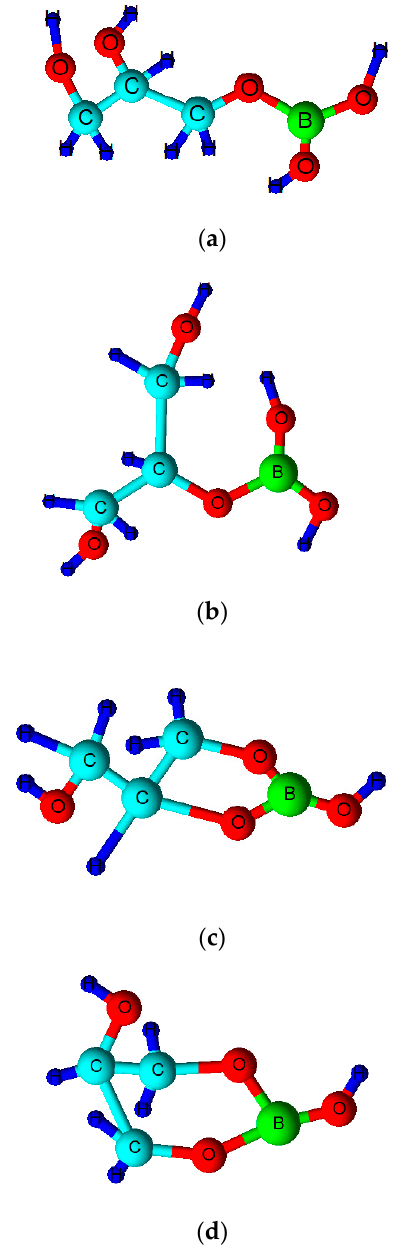
Figure 2. Molecular structures of boric acid/borate monoesters of glycerol. ( a ) sn -1(3)-monoester; ( b ) sn -2-monoester; ( c ) sn -1,2-cyclic diester with 5-membered heterocyclic ring; ( d ) sn -1,3-cyclic diester with 6-membered heterocyclic ring. Corresponding peroxoborate esters will contain a peroxo- function (-OOH) in place of one of the two free -OH ones in the case of structures ( a ) and ( b ), and in place of the only free -OH group in structures ( c ) or ( d ).